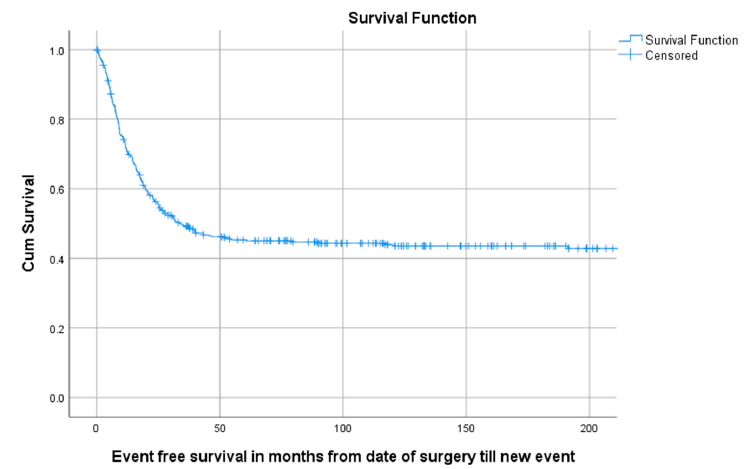
Figure 5. KM estimation of EFS of total cohort. Legend: EFS = Event-free survival, cum survival = cumulative survival. Table 3. OS and EFS at 5 years along with 95% confidence interval (CI).